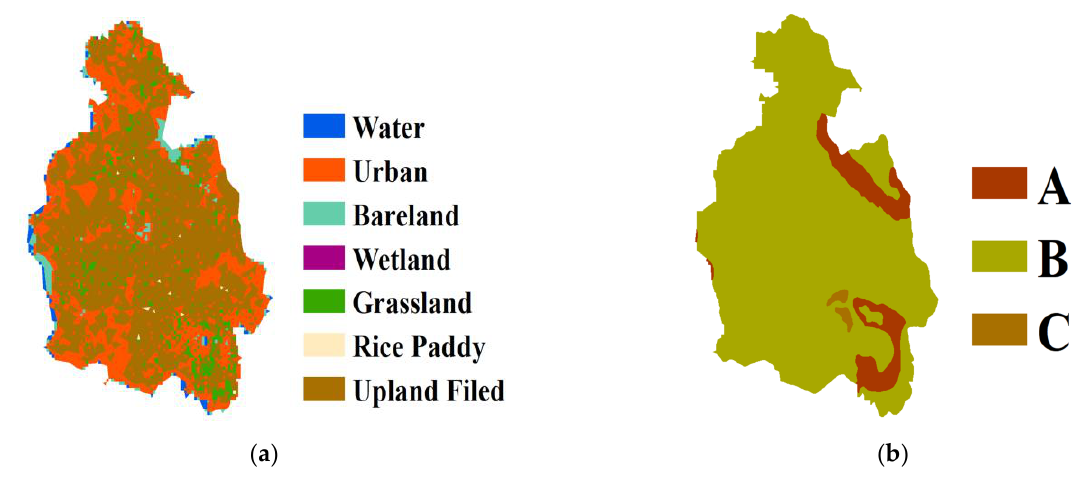
Figure 4. Maps of land use ( a ) and hydrological soil group ( b ).